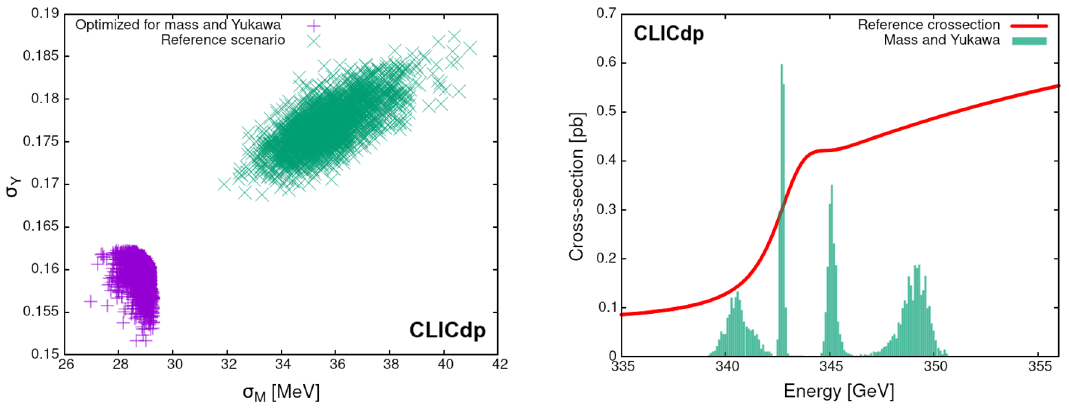
Figure 12 . As in figure 11 but for scan optimised for mass and Yukawa coupling determination